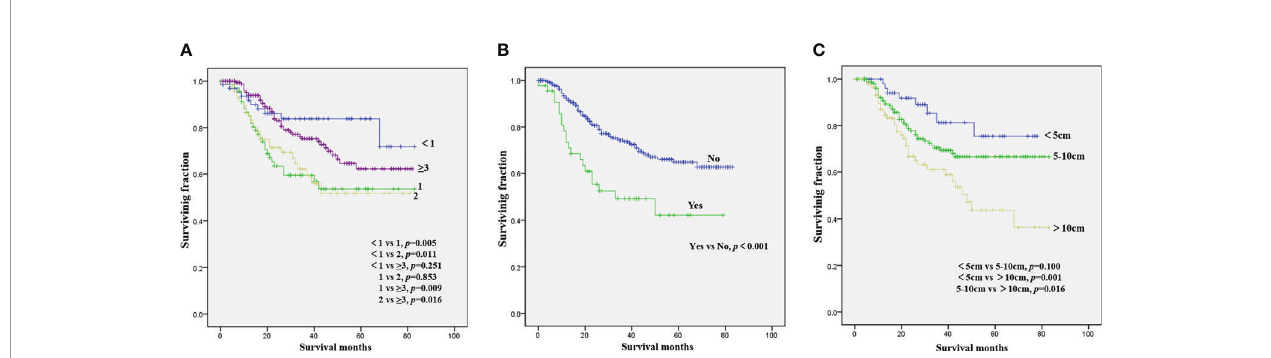
FIGURE 1 | Kaplan – Meier method for the estimation of OS in NB patients with bone metastasis at diagnosis strati fi ed by age (A) , lung metastasis (B) , and tumor size (C) . NB, neuroblastoma; OS, overall survival.